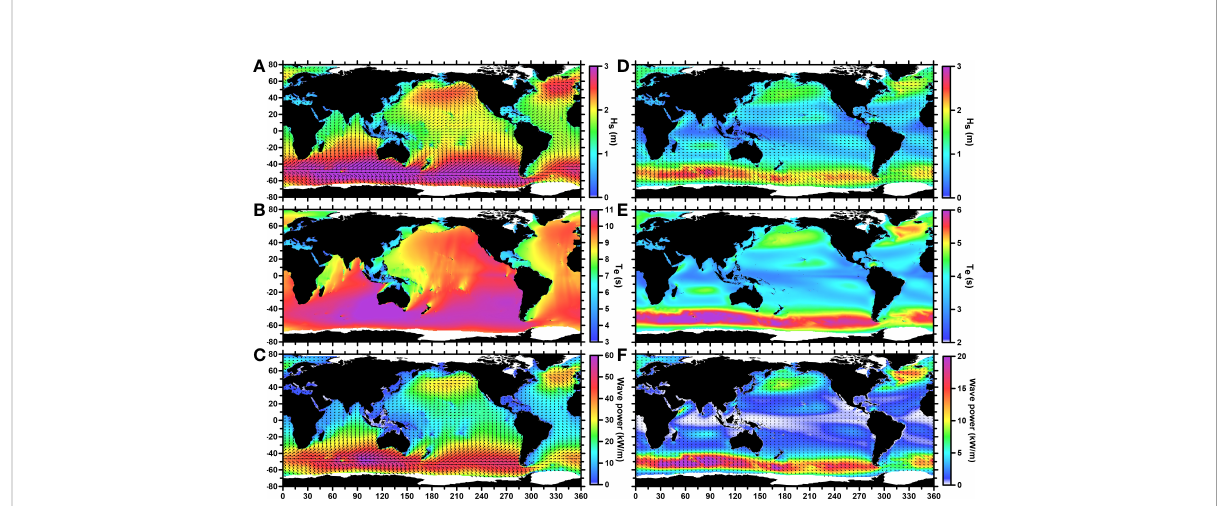
FIGURE 2 Swell and wind-sea wave components, as in Figure 1. Panels show H s , T e , and P w for the (A – C) swell and (D – F) wind-sea wave fi elds, respectively. Averaged wave powers of less than 1 kW/m are shown as approaching